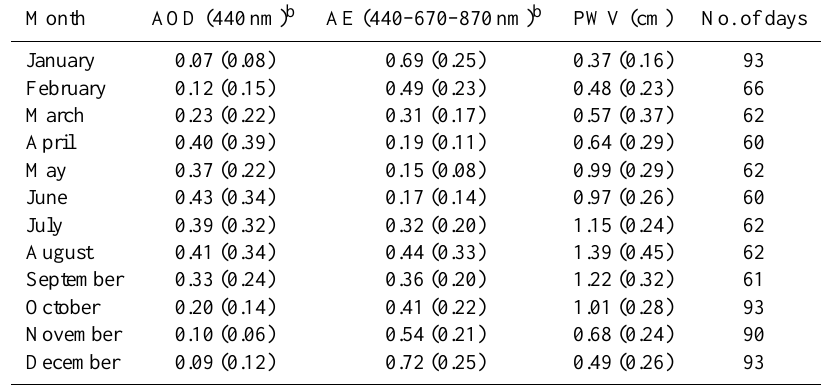
Table 3. Monthly means of AOD, AE, and PWV for the period October 2006 to February 2009 at Tamanrasset a . Month